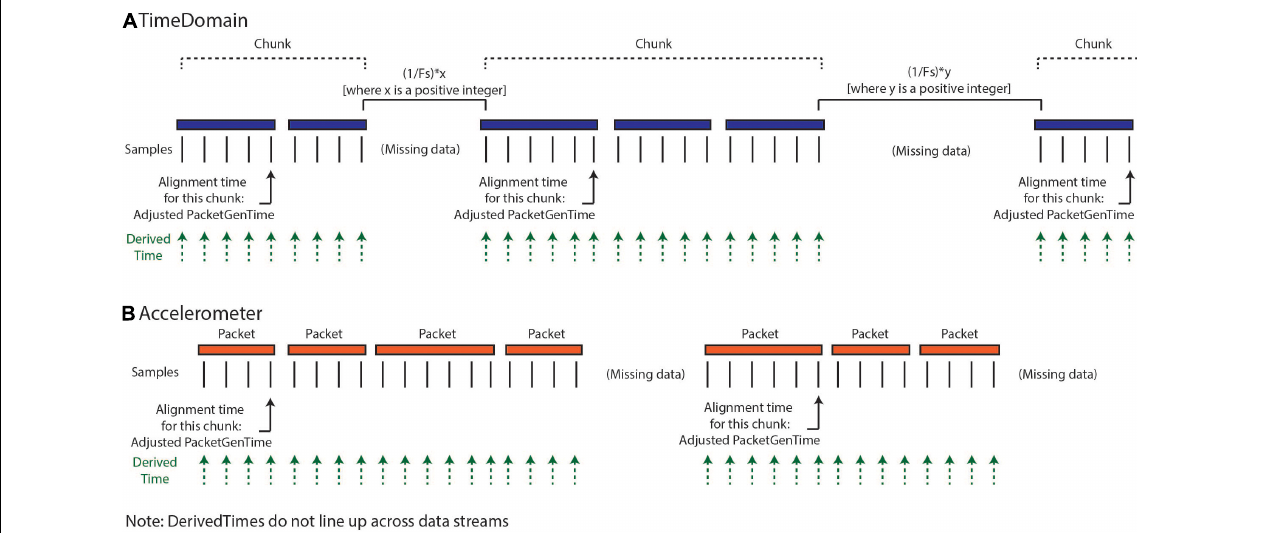
FIGURE 3 | Calculation of DerivedTimes for each data stream. (A) The default method for calculating DerivedTimes for short-gap chunks and the only method for long-gap chunks is to align the beginning of continuous chunks of data to Unix time using the adjusted PacketGenTime from the first packet in the chunk, and then using the sampling rate to determine the DerivedTime for each sample. Each DerivedTime is shifted to the nearest multiple of 1/Fs after chunk one in order to preserve consistent intersample spacing. (B) DerivedTime is calculated separately for each time series data stream, as each data stream has packets that are sent